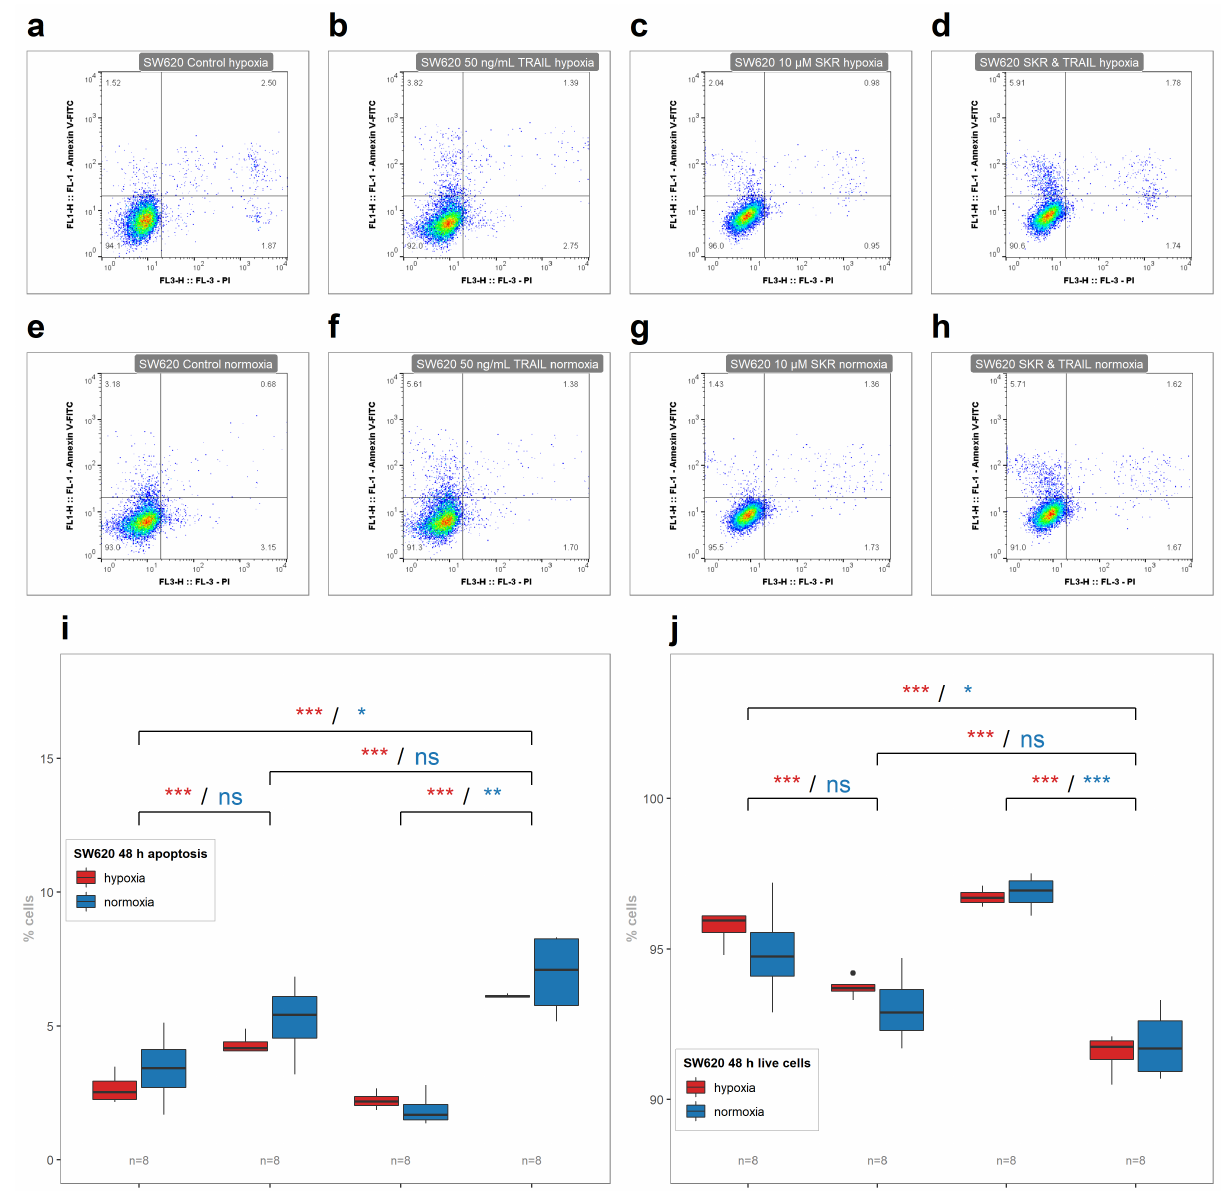
Figure 9. The effect of SKR in combination with TRAIL on the onset of apoptotic and live cells in SW620 cell line. ( a – h ) Representative FACS plots of debris-free singlets after SKR and TRAIL treatment in SW620 cell line. ( i ) Percentage of apoptotic cells after treatment with SKR and TRAIL after 48 h in SW620 cell line. ( j ) Percentage of live cells after treatment with SKR and TRAIL after 48 h in SW620 cell line. The experimental groups were compared with the matching control group or group, indicated with a line below marks. The color of the marks matches the cultivation conditions (hypoxia or normoxia). The number of samples (n) is noted in the plots. (* p < 0.05, ** p < 0.01, *** p < 0.001, ns—not